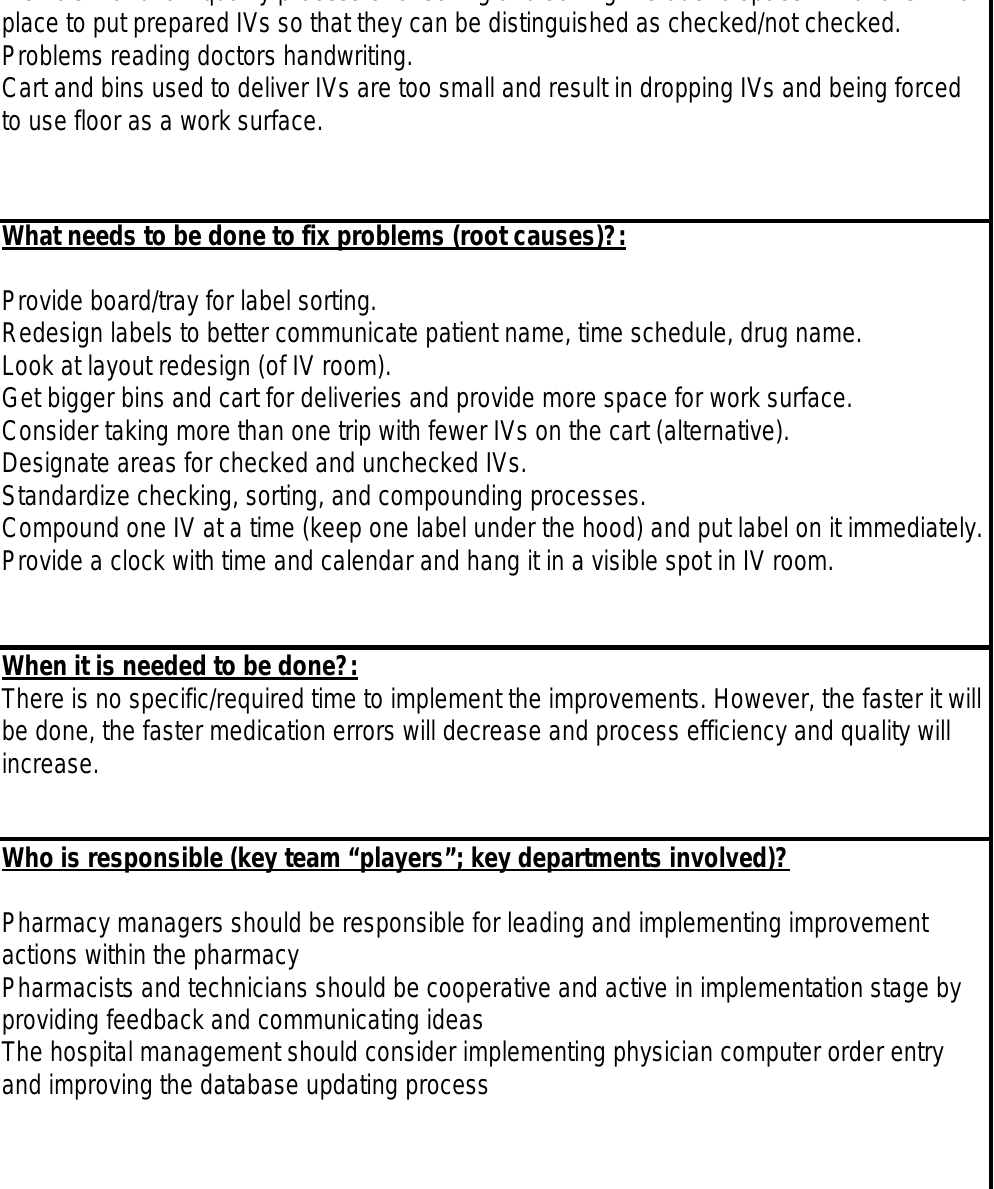
Figure 1b. “Map to Improve (M2I) Tool: Page